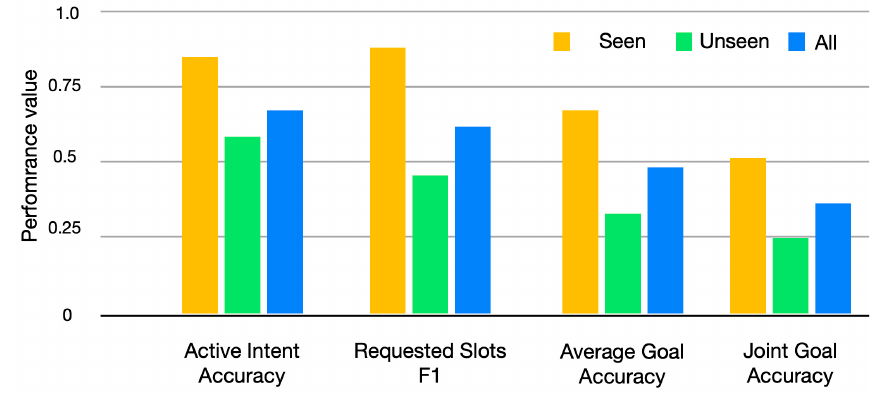
Figure 11. SG-CSE BERT model performance.